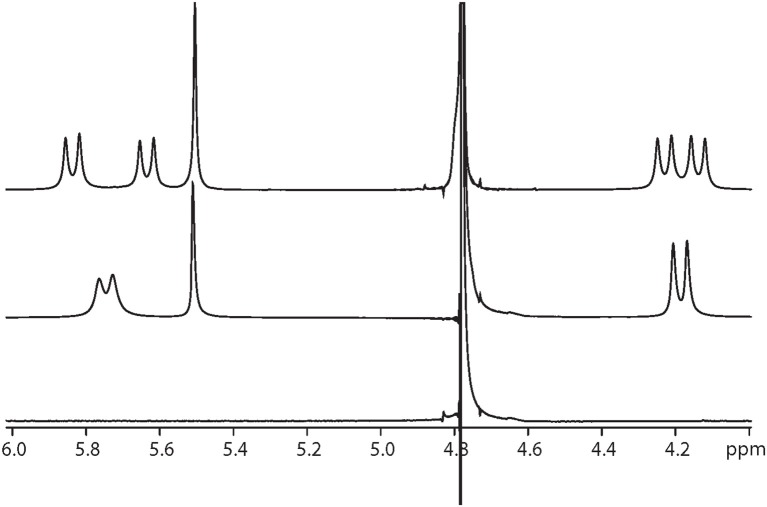
1H NMR spectrum of the protons from Q[10], at Q[10] to α-Me4phen-7 ratios of 0 (bottom spectrum), 0.75 (middle) and 1.0 (top).